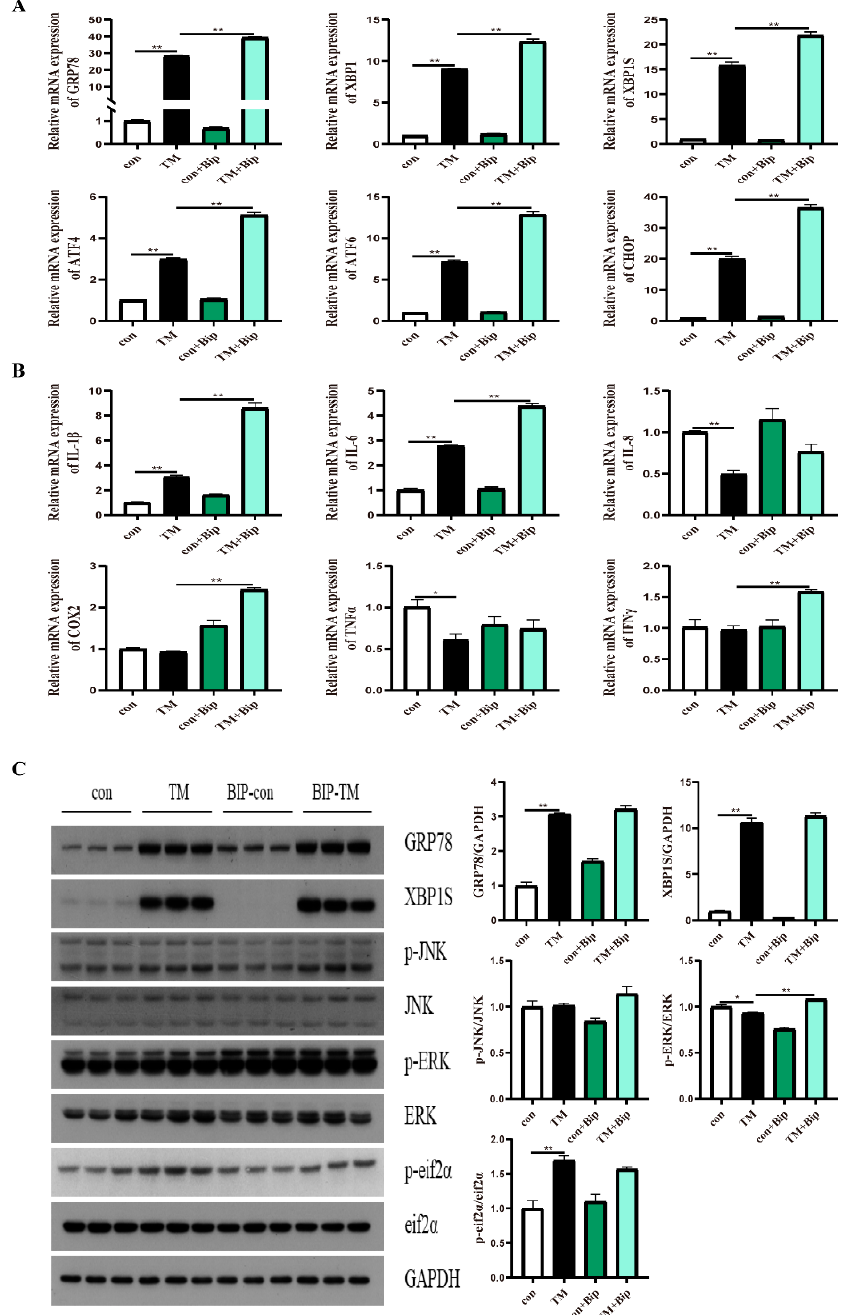
Figure 4. Effects of 10 µ M BiP treatment for 4 h before 1 µ M TM incubation for 16 h on ER stress and inflammation in macrophages of large yellow croakers. ( A ) Relative mRNA expression of ER stress-related genes. ( B ) Relative mRNA expression of inflammatory genes. ( C ) Protein levels of ER stress-related proteins and inflammatory-related proteins. Values are presented as mean ± SEM ( n = 3). * Significant difference ( p < 0.05); ** highly significant difference ( p < 0.01).